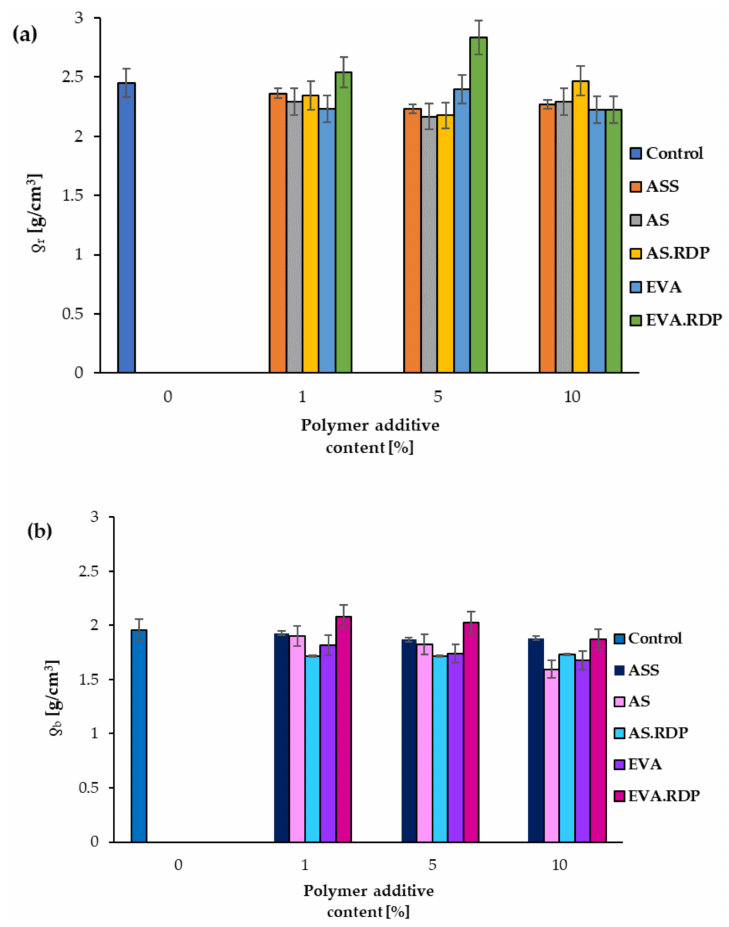
Figure 10. The particle ( a ) and bulk ( b ) density of the studied